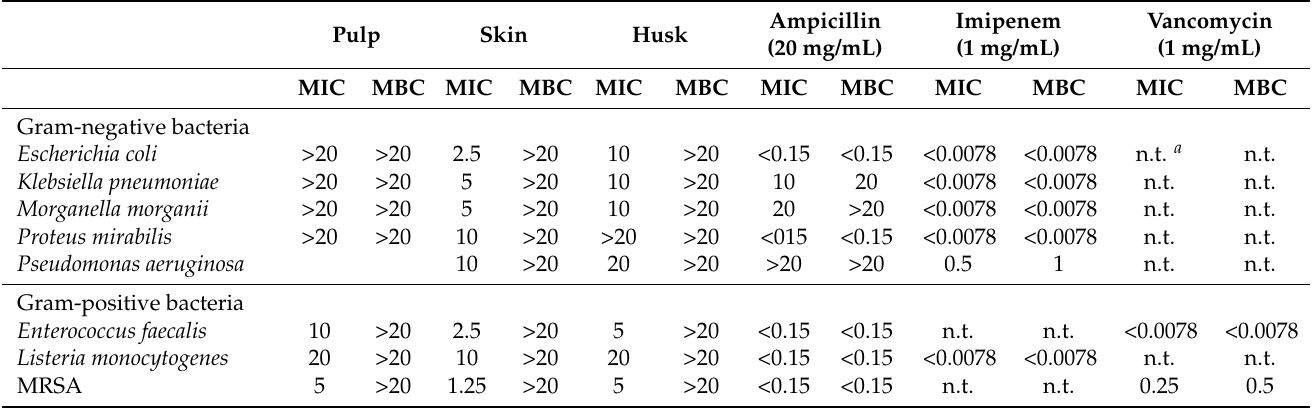
Table 4. Antimicrobial activity of the ethanolic extracts of pulp, skin, and husk of Aesculus hippocas- tanum fruits.